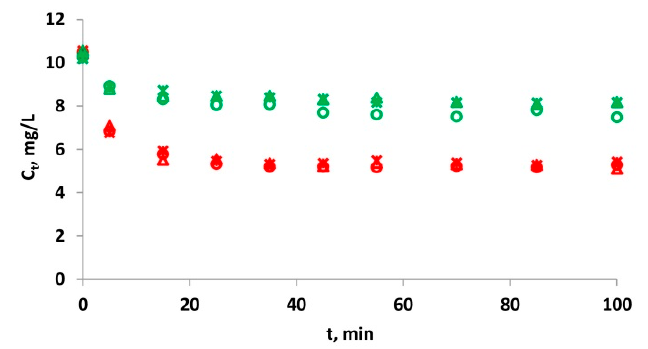
Figure 3. The equilibrium state of Mn sorption on tuff (T) and basalt (B) at temperature 10, 17.5 and 25 ° C.